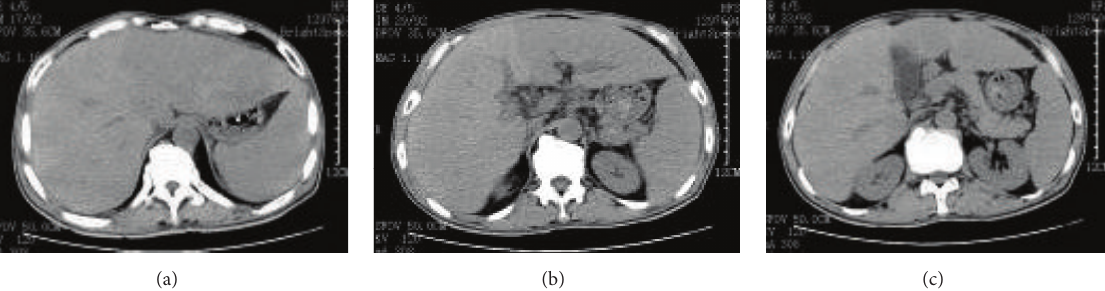
Figure 1: Epigastrium CT before treatment. Note: the liver outline was significantly more prominent. The liver edge was less smooth. Liver parenchymal density was uneven. Patchy low-density shadows were observed, especially in the left live. Multiple quasicircular low-density foci appeared in the right lobe of the liver. The spleen was enlarged to about seven rib units. The density was uniform.